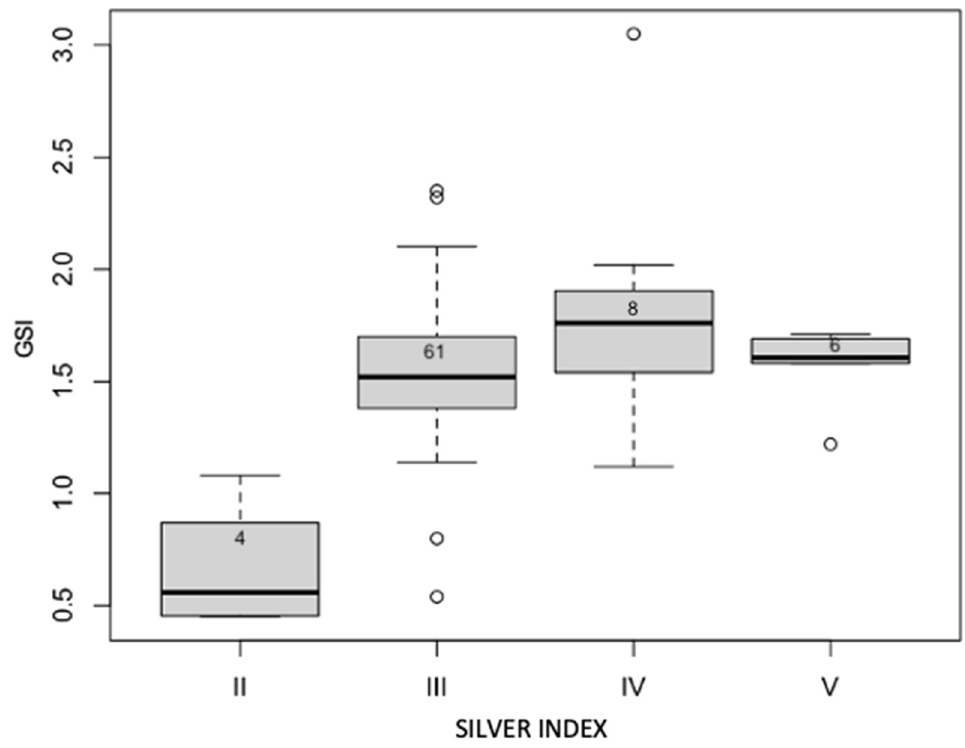
Figure 6. Relation between silvering stages and GSI values of sampled eels.